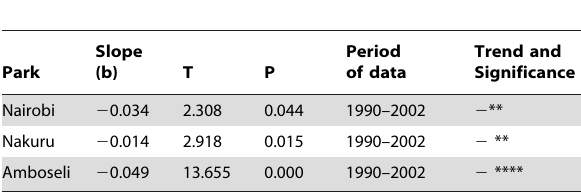
Table 2. Trends in large mammal populations in the three smallest National Parks of the study from 1990 onwards.